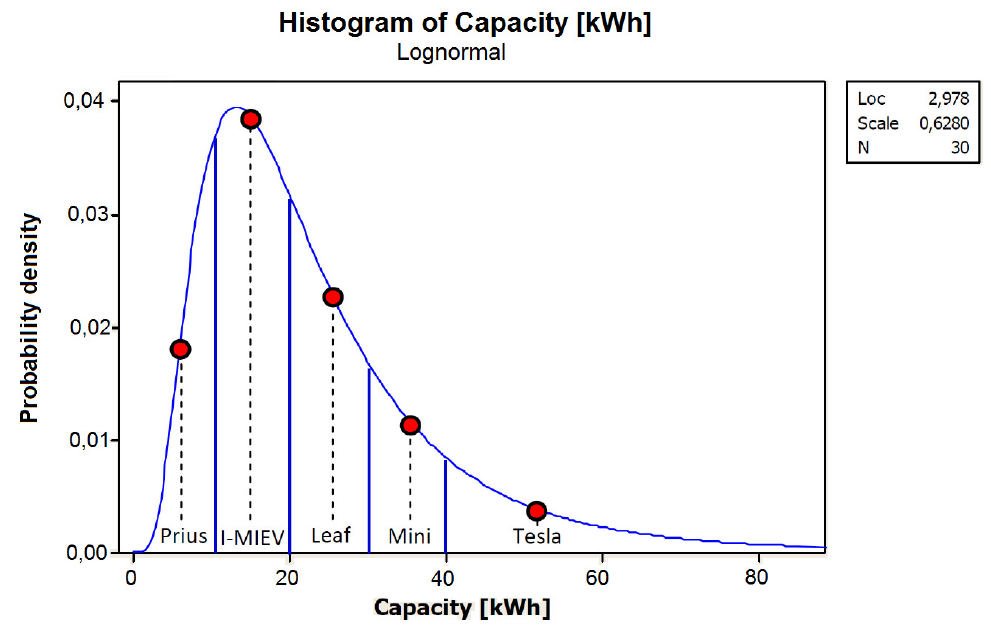
Figure 8. Distribution function of the batteries